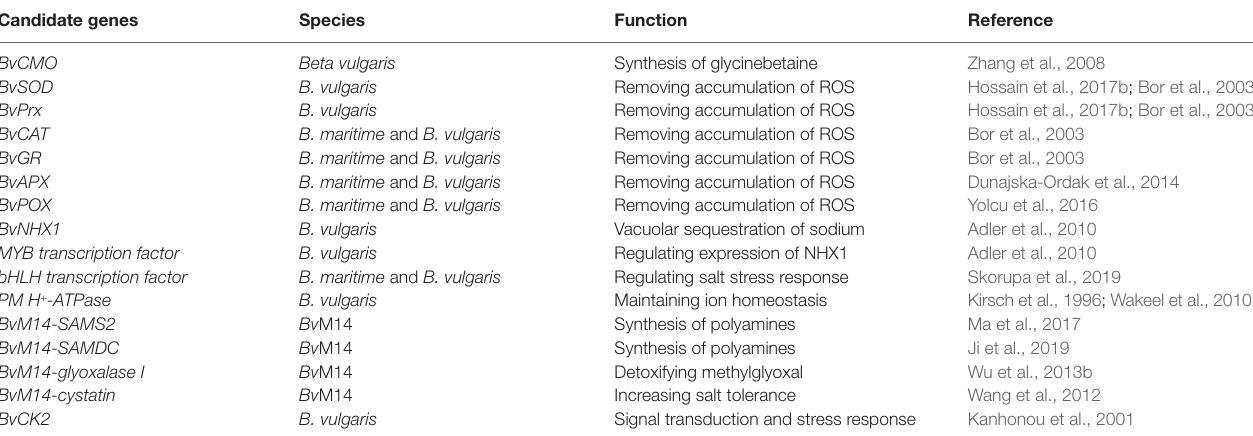
TABLe 2 | Candidate genes for improving salt tolerance in sugar